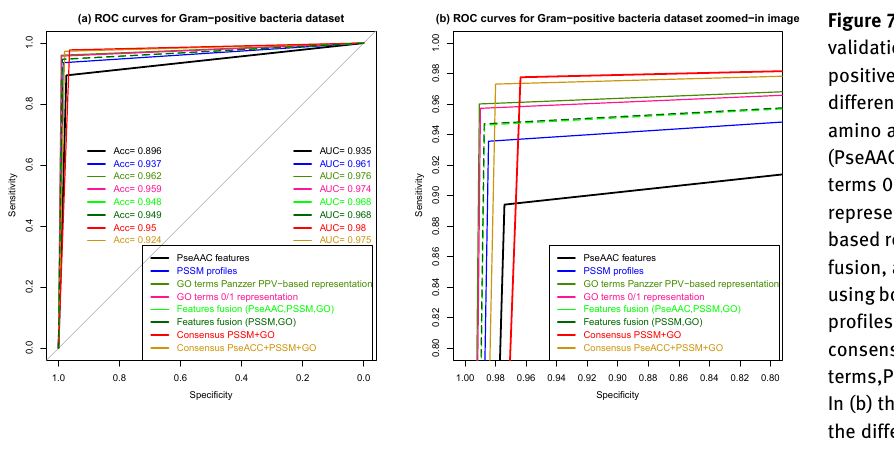
Figure 7: ROC curves of cross- validation tests on Gram- positive bacteria dataset for different predictions pseudo- amino acid composition (PseAAC), PSSM profiles, GO terms 0/1-based representation, GO terms PPV- based representation, features fusion, a consensus prediction usingbothGOtermsandPSSM profiles outputs and a consensus of PseAAC, GO terms,PSSM profiles outputs. In (b) the zoomed-in image of the different